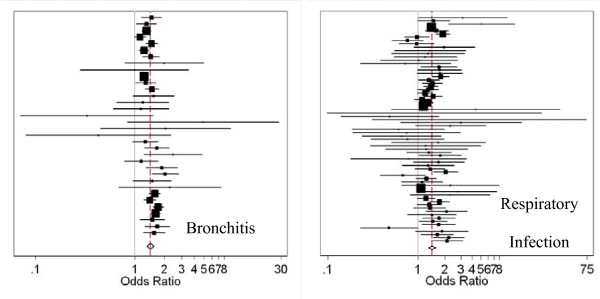
Odds ratios and confidence intervals from all studies meeting the less restricted eligibility criteria and from a meta-analysis of these studies performed using the random effects model and assuming dependent estimates within studies. The width of the boxes (some so small they appear as points) is proportional to the precision of the study and the ends of the horizontal lines represent lower and upper 95% confidence limits. The left vertical line marks an odds ratio of 1.0, corresponding to no increased risk, while most of the reported odds ratios are greater than unity indicating an increase in risk with dampness and mold. The central estimate from the meta-analysis is indicated by the right vertical line and the left- and right-side points of the diamond at the bottom of the figure indicate the lower and upper 95% confidence limits from the meta-analyses.